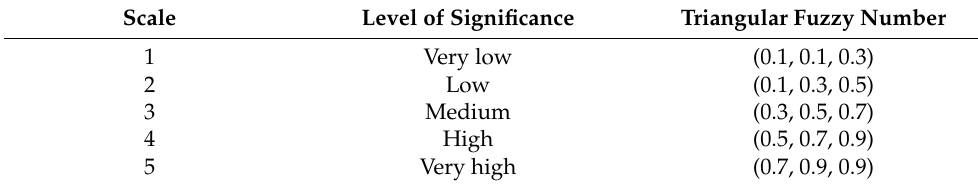
Table 2. Linguistic scale and their associated